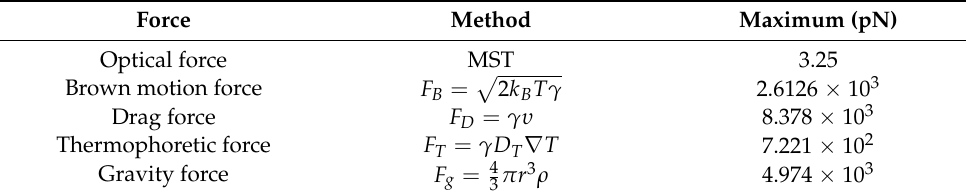
Table 1. The components of the force on the